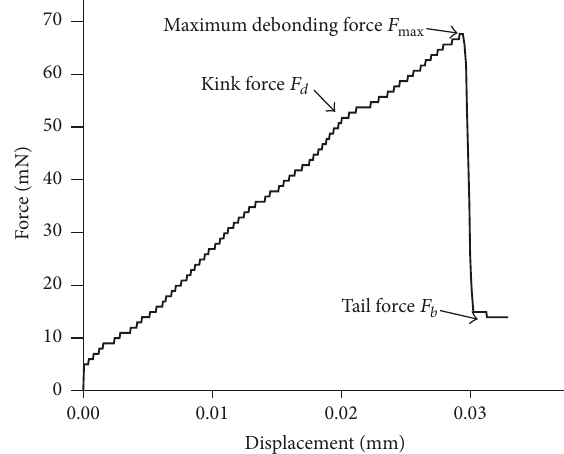
Figure 2: Load-displacement curve for the microdroplet test.